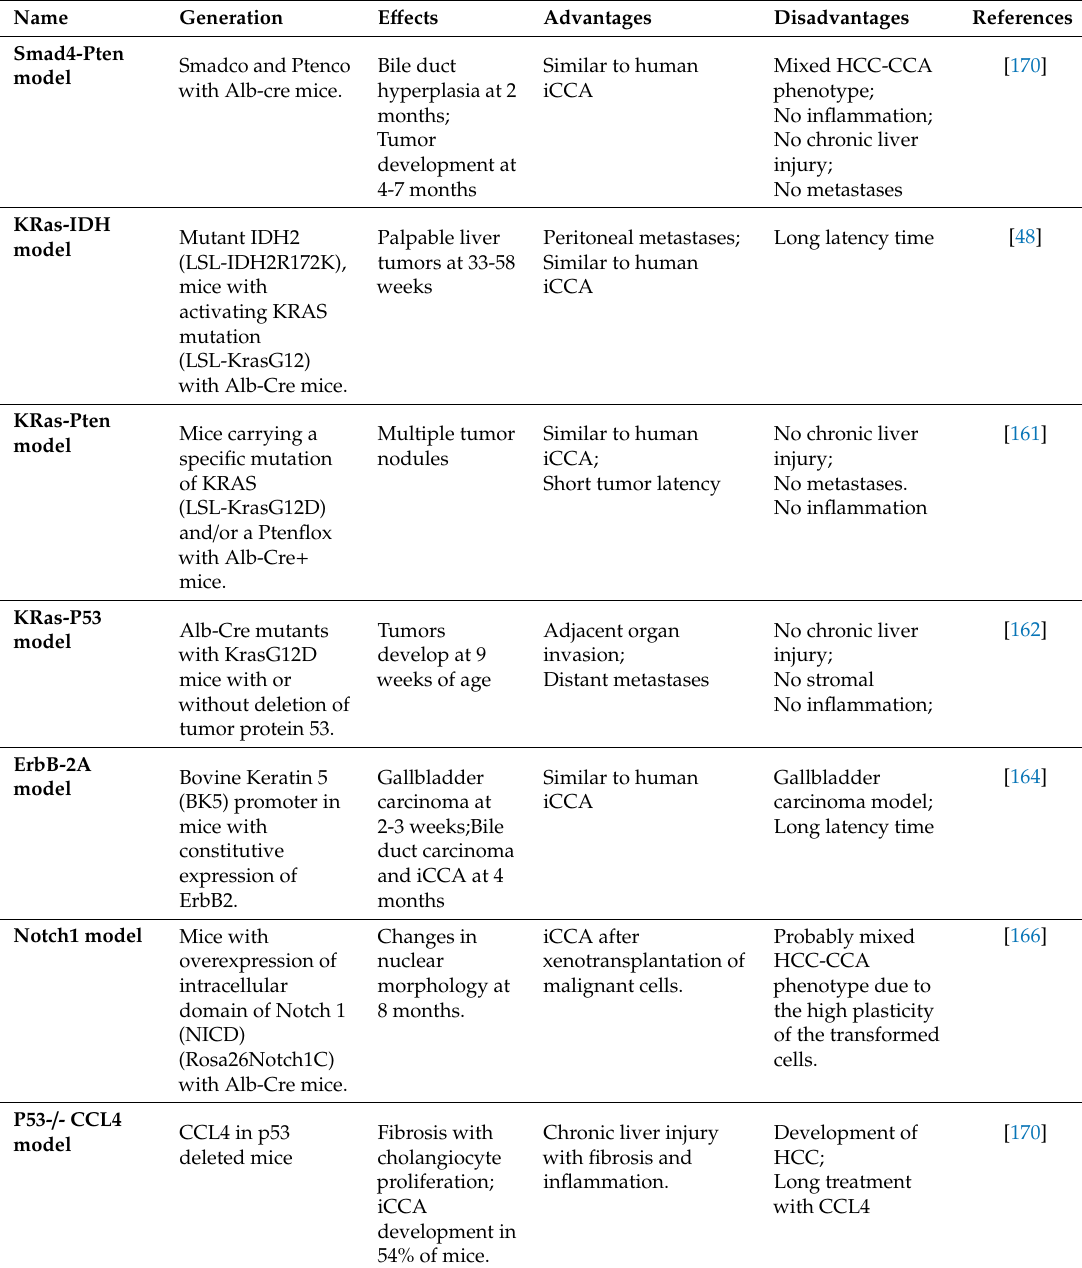
Table 3. CCA transgenic mouse models described in the